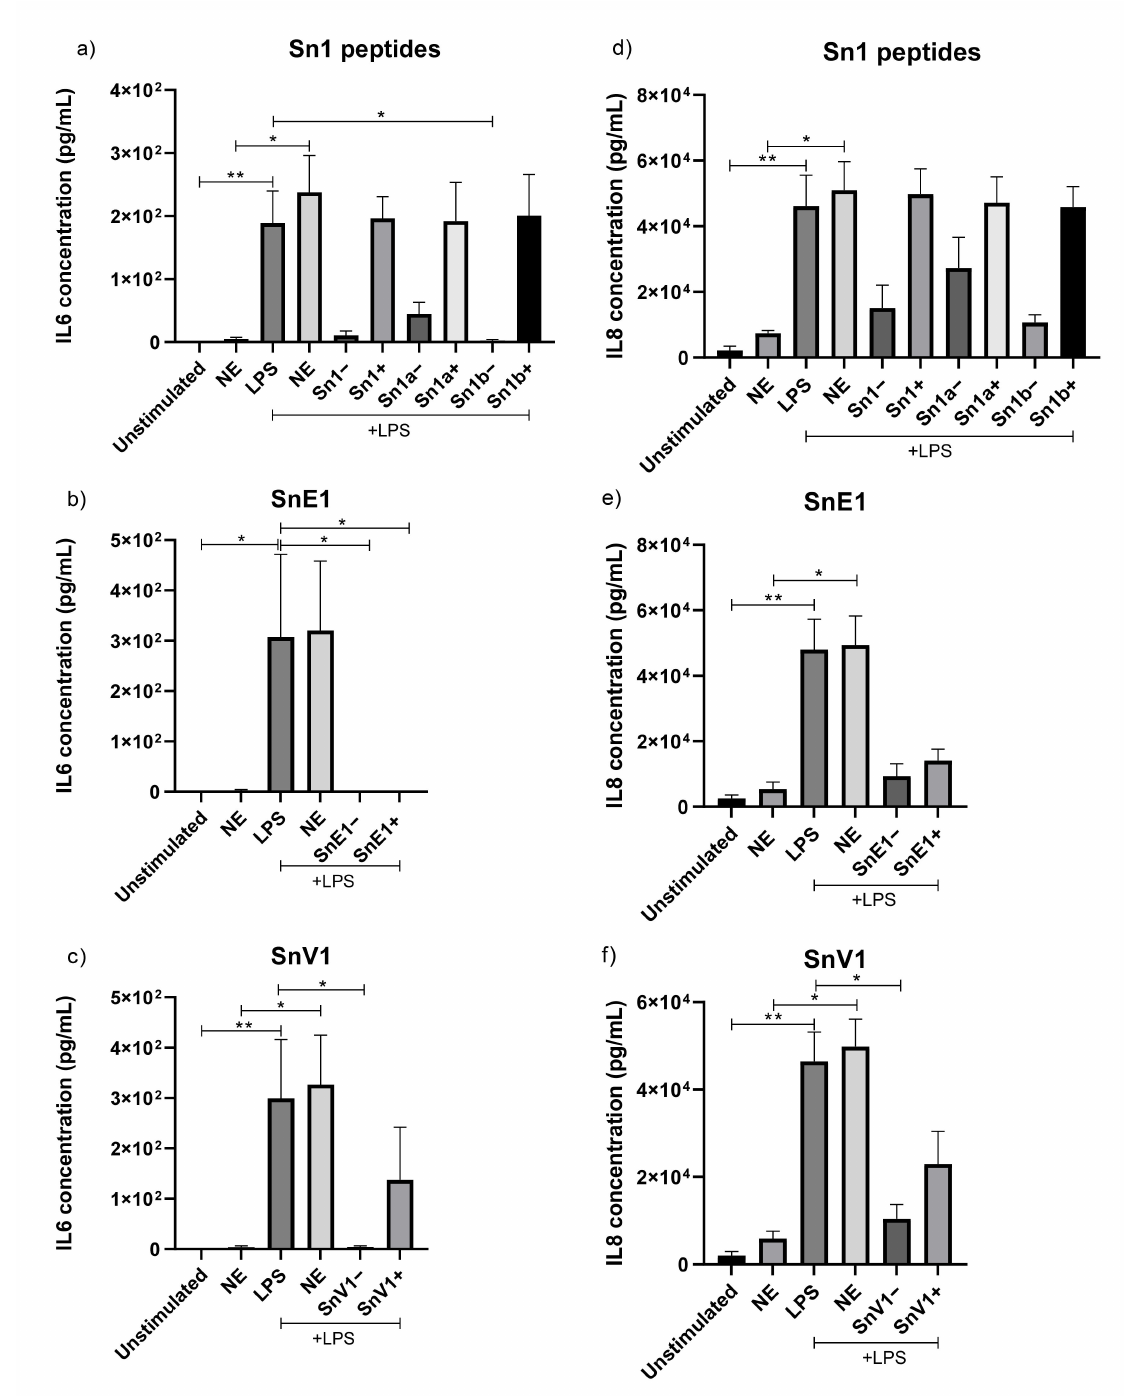
Figure 4. IL-6 and IL-8 concentrations in the supernatant of THP-1 monocyte-derived macrophages. THP-1 monocyte- derived macrophages were incubated with 5 µ g/mL of NE-incubated or control ( a , d ) Sn1, Sn1a, Sn1b, ( b , e ) SnE1, ( c , f ) SnV1 and/or 100 ng/mL of LPS for 16 h. ( a – c ) IL-6 and ( d – f ) IL-8 levels in cell supernatants were then measured via ELISA. Kruskal–Wallis with Dunn’s Multiple Comparison * p < 0.05, ** p < 0.01, n = 3–4. +/ − = incubation with/without NE immediately prior to the